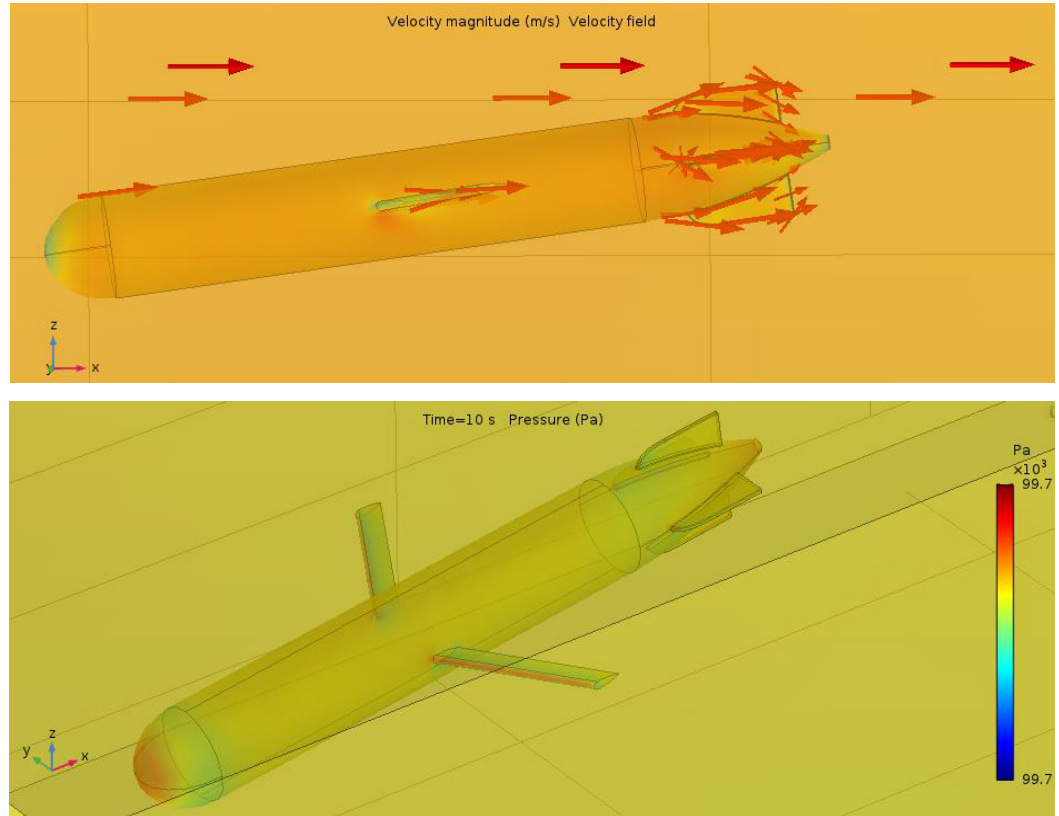
Figure 4. The velocity fields, streamlines and pressure distribution with torpedo velocity U = 1 m/s and angle of attack θ = −10 ° .